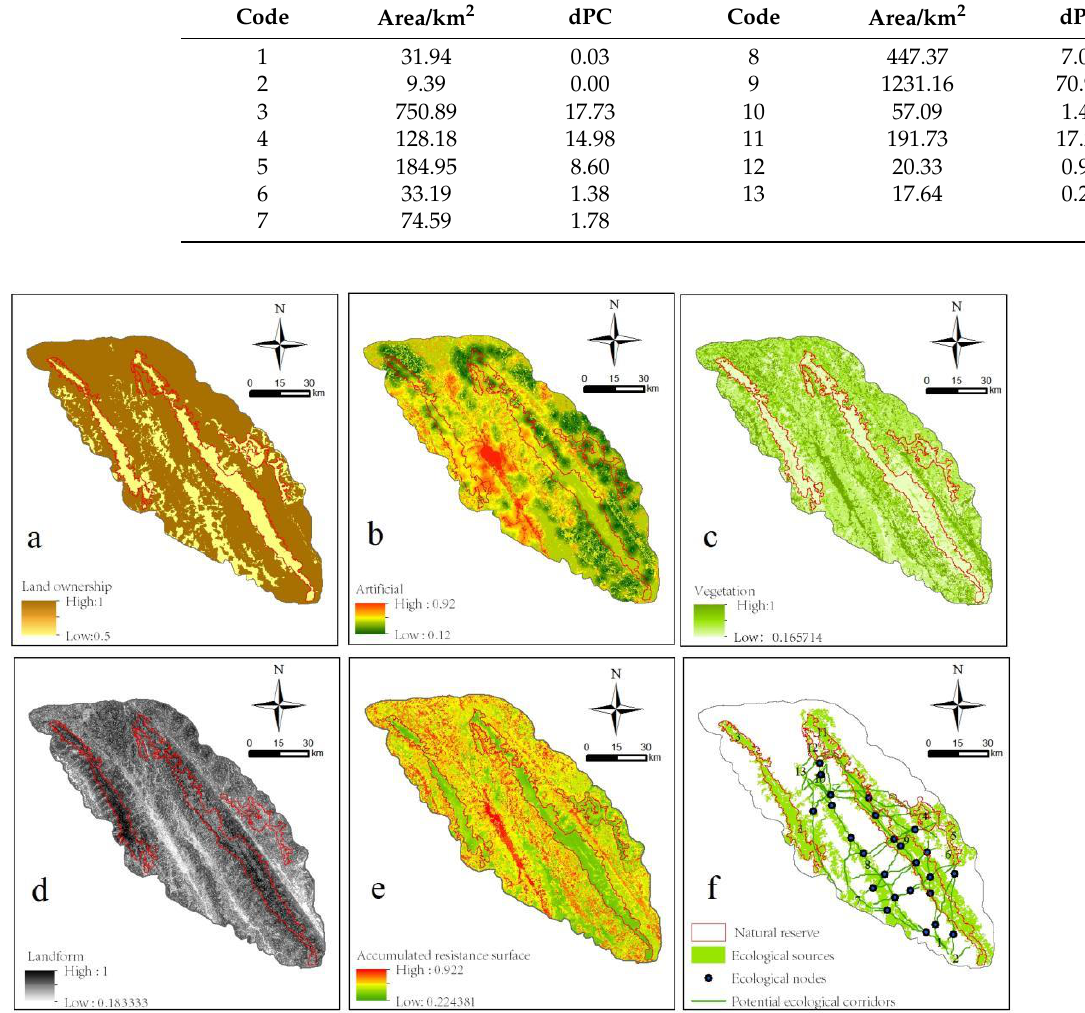
Figure 3. Composite resistance surface of species migration in national park. ( a ) Land ownership; ( b ) artificial; ( c ) vegetation; ( d ) landform; ( e ) accumulated resistance surface; and ( f ) potential ecological corridors.